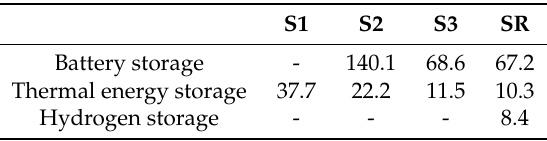
Table 10. Full storage cycles per